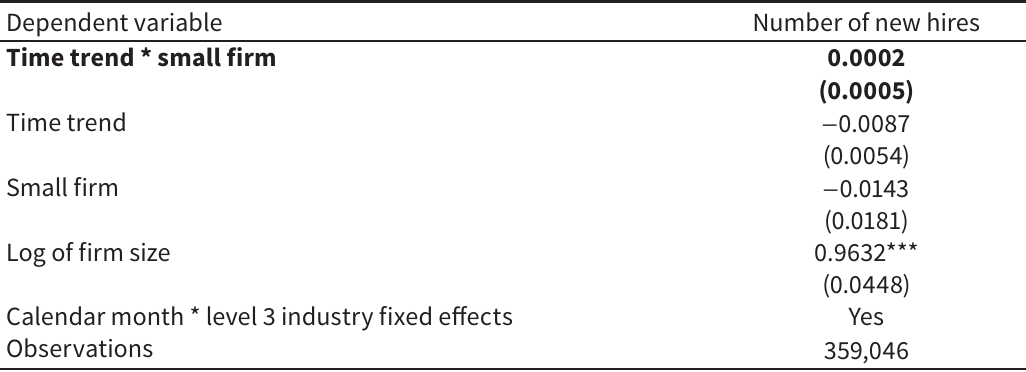
Test for parallel trends in the pre-announcement